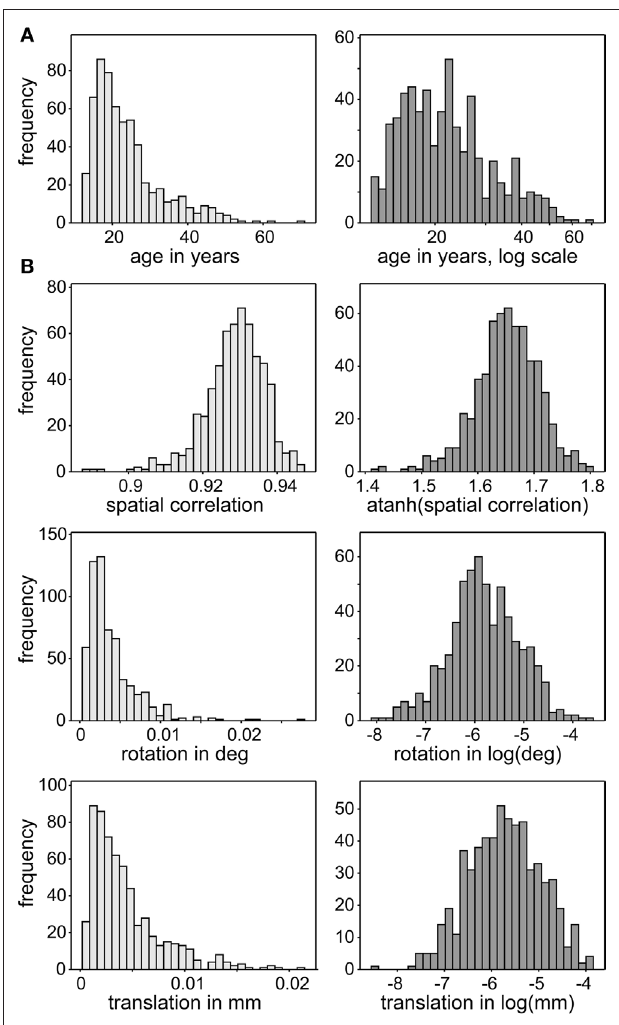
FIGuRe 2 | Distributions of continuous covariates of interest (A) and nuisance predictors (B). Distributions of covariates are skewed (light gray, left panels) so are transformed to have more symmetric distributions (dark gray, right panels). This reduces disproportionate influence of more extreme observations on the MANCOVA and univariate model